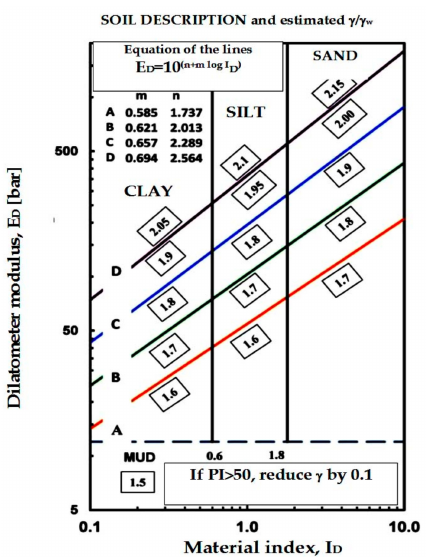
Figure 1. Unit weight estimate from dilatometer (DMT) indexes E D and I D [25]. Reproduced with permission from [25], Marchetti, S.,